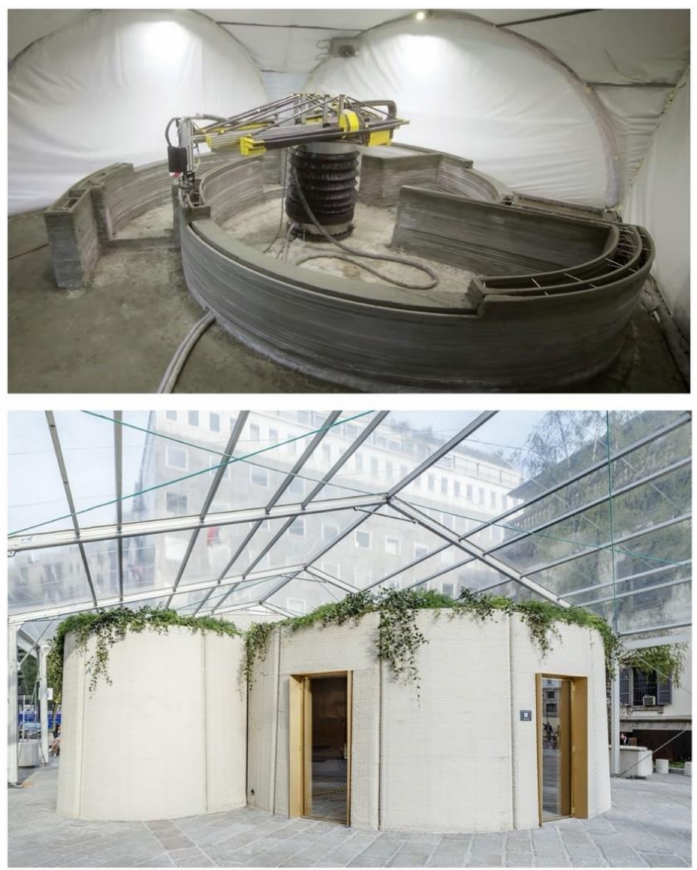
Figure 1. Examples of printed constructions by companies Apis-Cor, reprinted from [4], and Cybe, reprinted from [5]. The pictures show the printing process of a house and an exhibition prototype built in Milan,